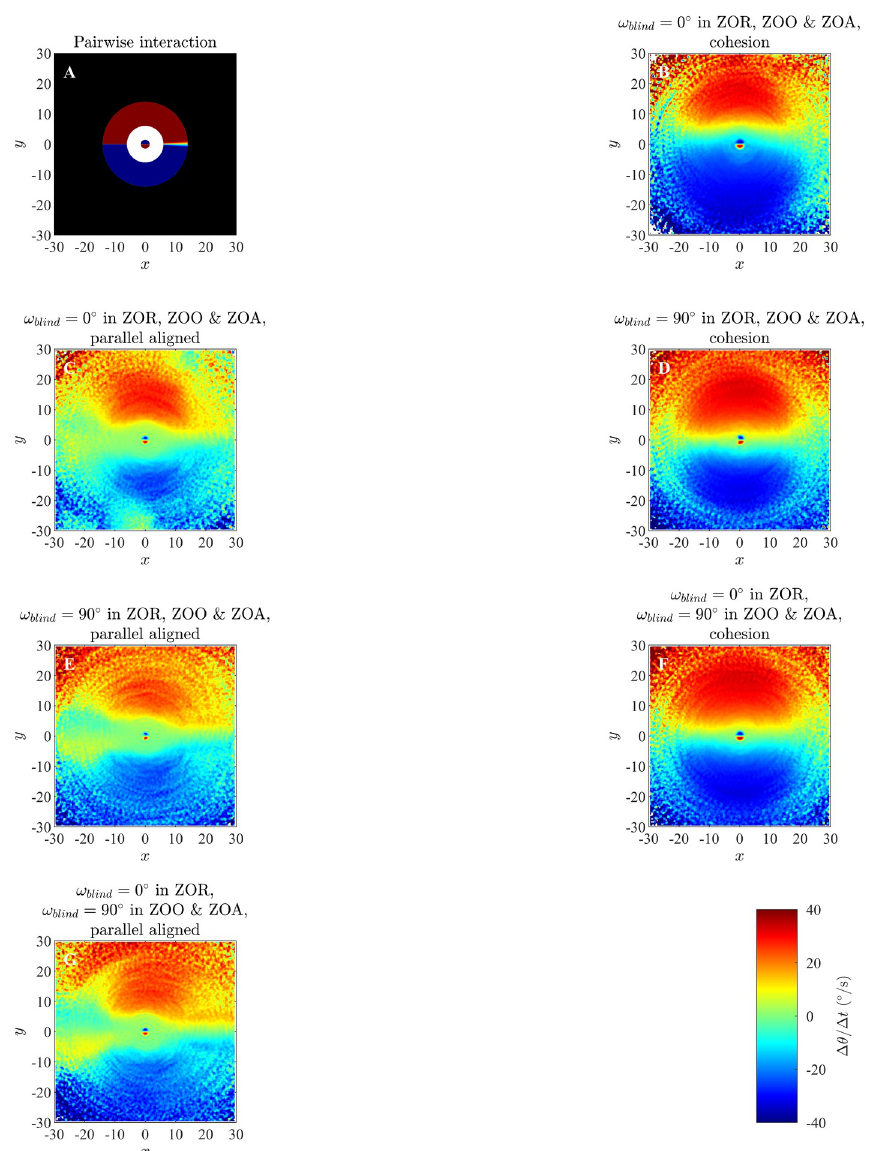
Fig 3. Panel A: analytical pairwise interactions for given parameter values, as described in S3.1 Section, where turning of the individuals is governed by equations (S3.5) and (S3.10). Panels B, C, D, E, F and G illustrate changes in direction of motion of individuals as a function of the relative positions of partners obtained via analysis of simulations with r 1.5, Δ r o = 4.5 and Δ r a = 8 using the averaging method. Positive changes in angle of motion indicate a turn to the left by the focal individual, whereas negative changes in angle of motion indicate a turn to the right. (Derived from simulations with N = 25 individuals over 1000 time